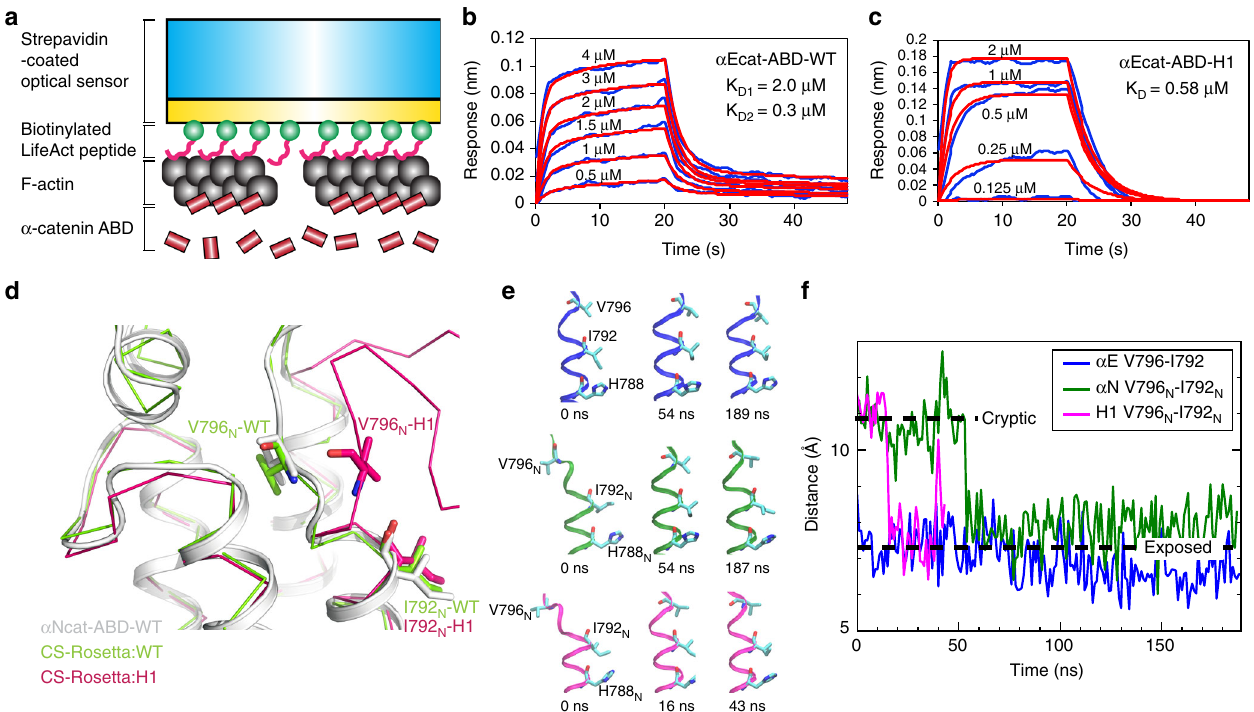
Fig. 6 Unfolding of α 1-helix affects the conformational dynamics of V796. a A scheme of BLI experiment for a kinetic analysis of direct interaction between α Ecat-ABD and F-actin. The streptavidin-coated optical sensor with LAbio peptides immobilizes F-actin through high avidity, thereby restricting the movement of attached F-actin to minimize the occurrence of α cat-ABD-induced actin bundling. b BLI responses curves of the α Ecat-ABD-WT. The K D values were obtained by fi tting concentration-dependent F-actin binding curves (blue) to a 2:1 heterogeneous binding model (red curves). c BLI response curves of the α Ecat-ABD-H1. The K D value was obtained by fi tting concentration-dependent F-actin binding curves (blue) to a 1:1 binding model (red curves). d CS-Rosetta-CM models of α Ncat-ABD-WT and α Ncat-ABD-H1 based on NMR CS data and the α Ncat-ABD-WT crystal structure as the template. e Conformational states of V796 during the equilibrium MD simulations of α Ecat-ABD-WT (blue), α Ncat-ABD-WT (green) and α Ncat-ABD-H1 (magenta). Snapshots of the region of α 5-helix containing V796 at speci fi ed time points are shown. f Evolution of distance between the β -carbon atoms of V796 and I792 during the equilibrium MD simulations. Dotted lines mark the approximate inter-residue distances when V796 is in the cryptic and